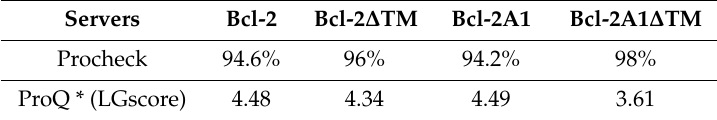
Table 1. Model performance in terms of structural analysis.